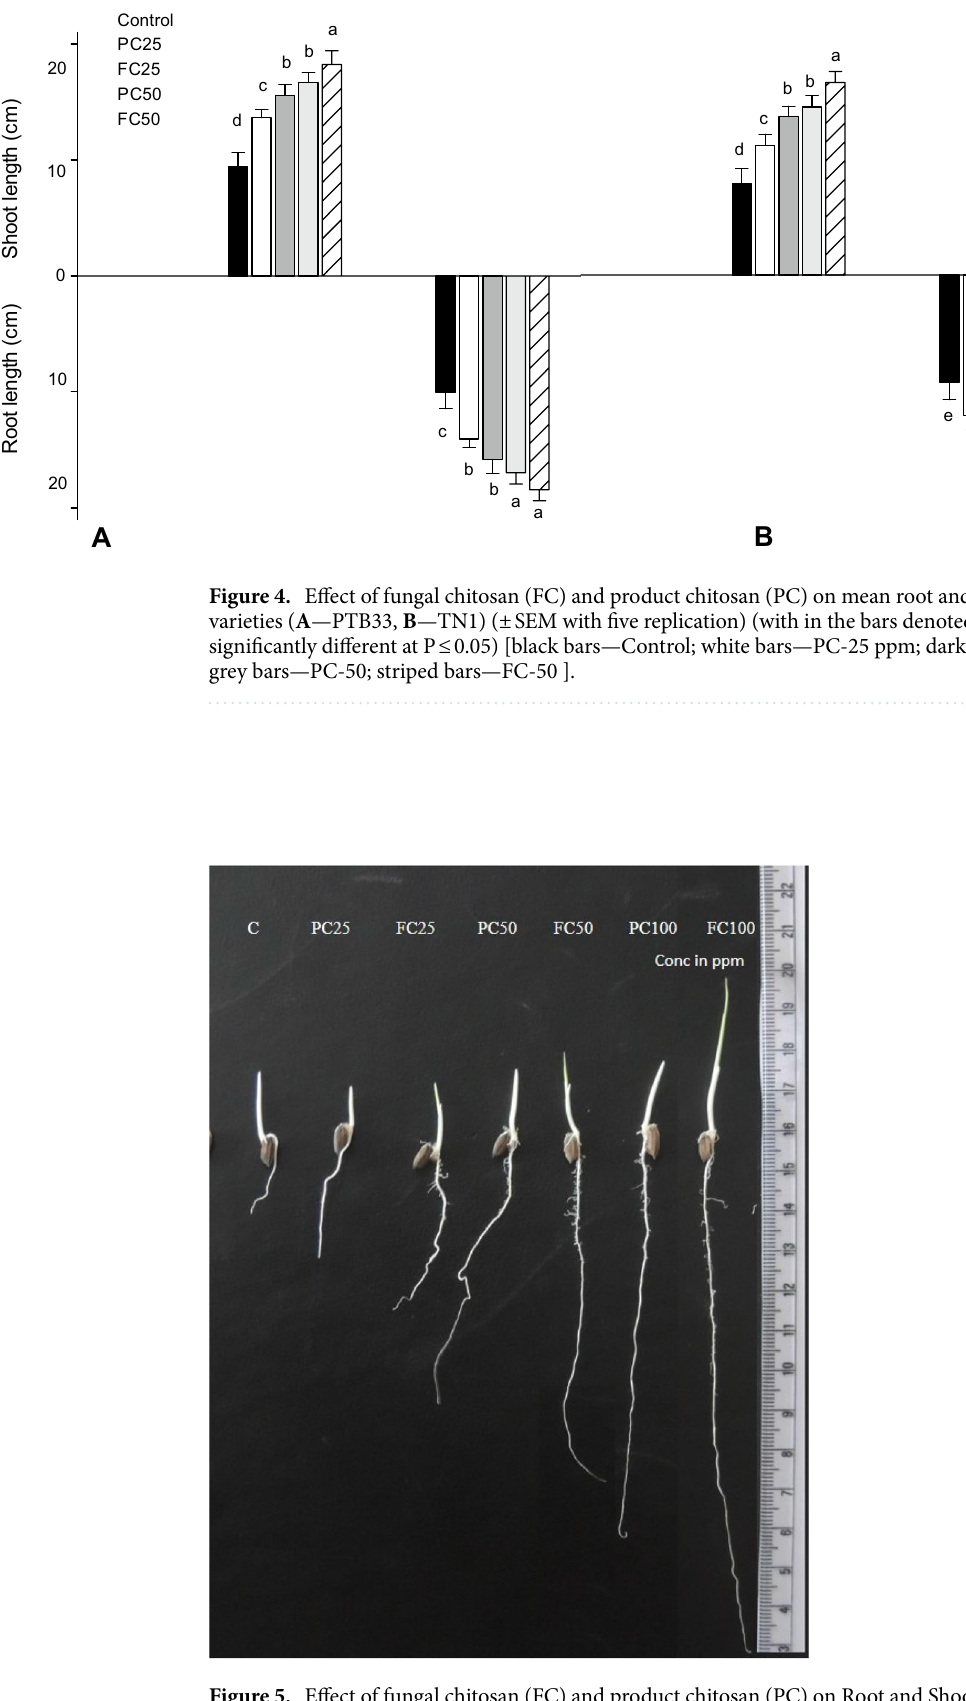
Figure 5. Effect of fungal chitosan (FC) and product chitosan (PC) on Root and Shoot